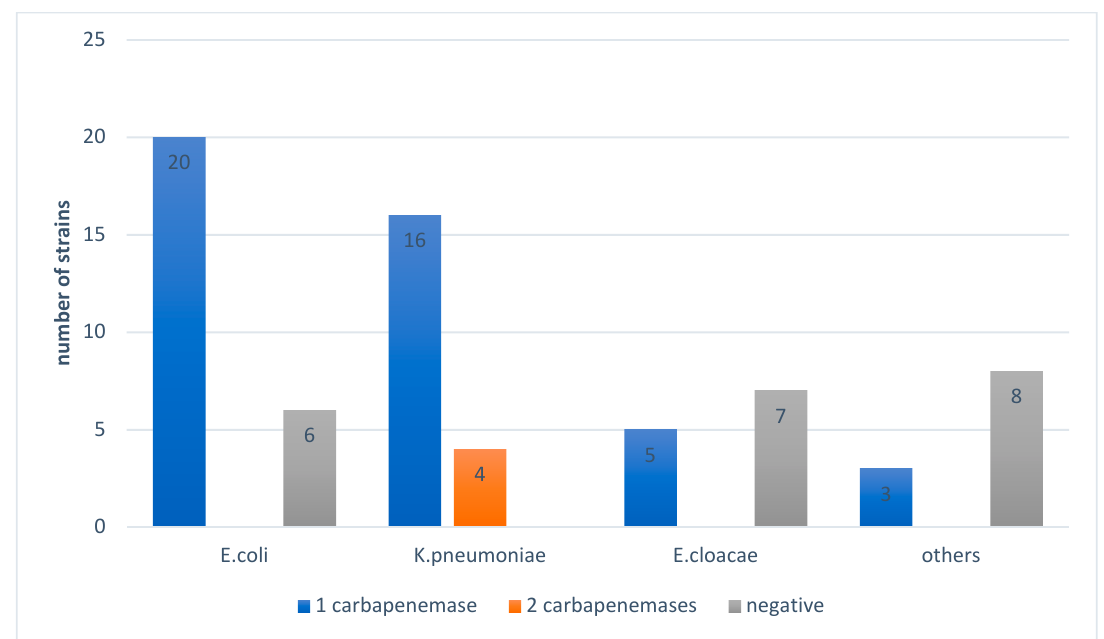
Figure 4. Distribution of the strains isolated according to the number of genes found. Figure 5 shows a predominance of OXA-48 in E. coli and K. pneumoniae and a pre- dominance of OXA-48 + NDM coexistence in R. terrigena .